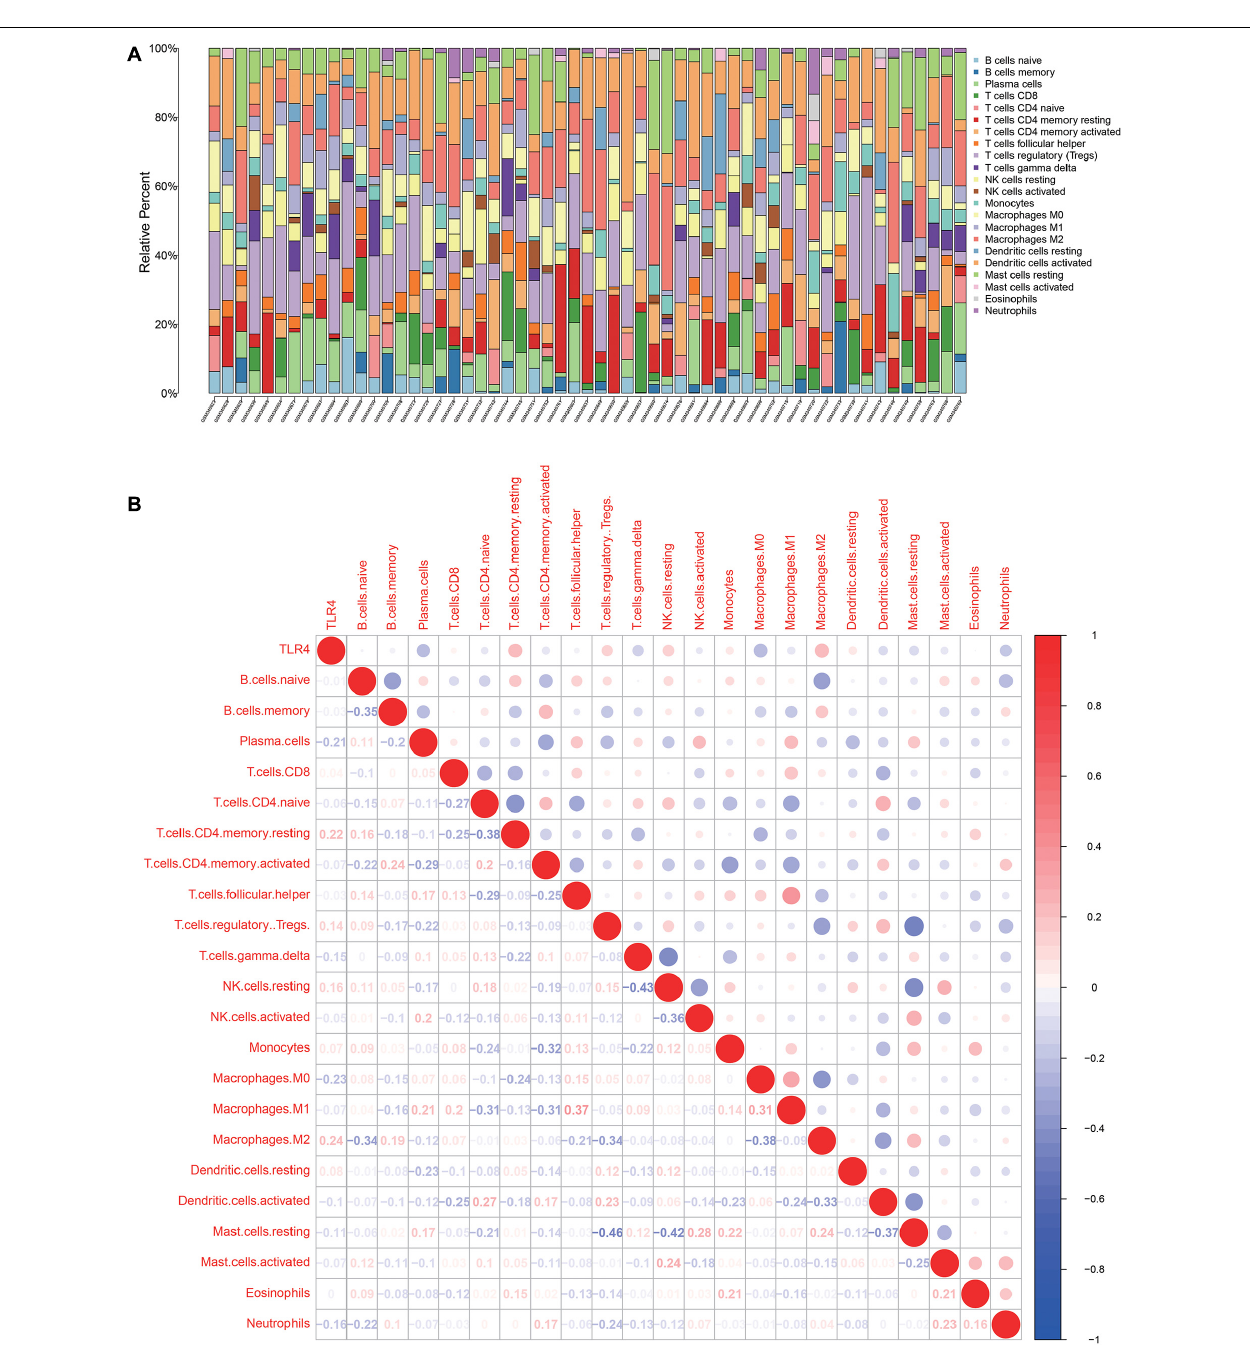
FIGURE 4 | Tumor microenvironment of tumor tissues from GSE13507. (A) Infiltrating immune cell profiles of each sample with P < 0.05. (B) Correlation between TLR4 expression and infiltrating immune cells.